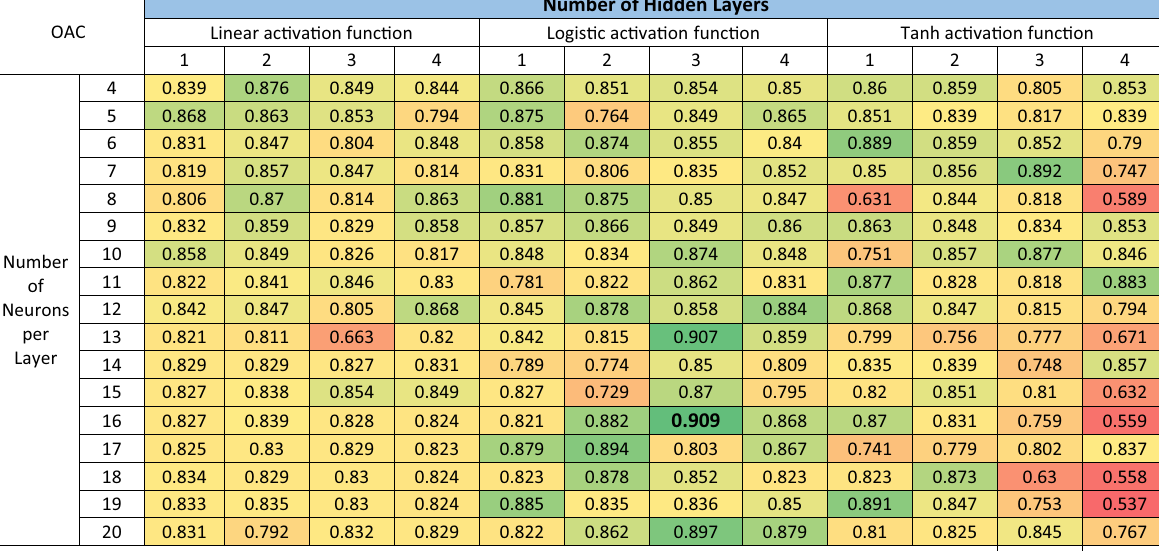
Number of Hidden